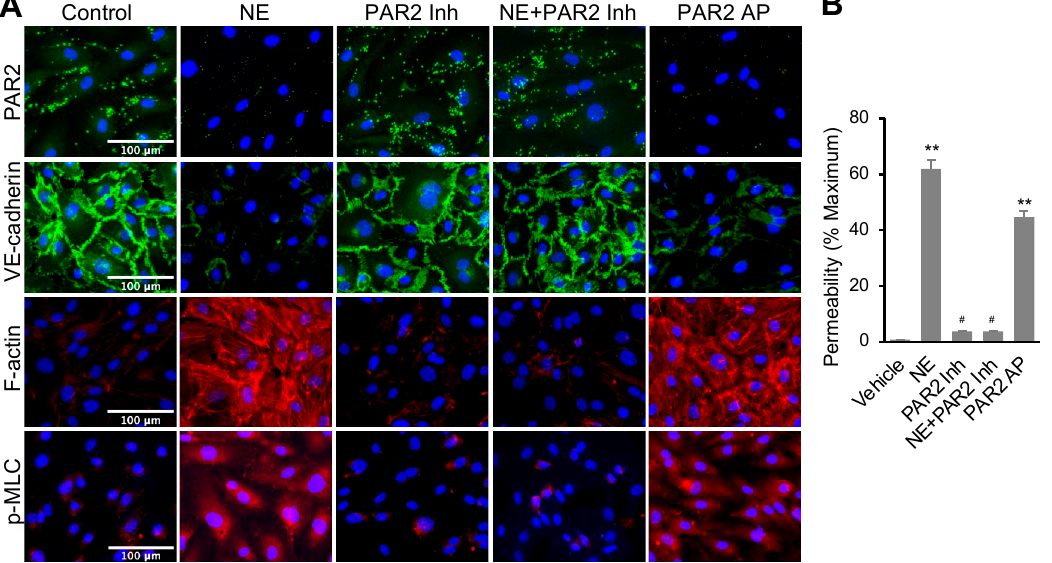
Figure 2. NE regulated VE-cadherin, actomyosin cytoskeleton, and permeability in hECs through activating protease-activated receptor 2 (PAR2). ( A ) Immunofluorescence images of PAR2 (green), VE-cadherin (green), F-actin (red), or p-MLC (pSer19, red) and nuclei counterstaining DAPI (blue). hEC cells were treated with NE (20 nM) or PAR2 agonist (PAR2-AP, 7.5 μ M) in the presence or absence of PAR2 inhibitor (1 μ M) for 16 h. Images were taken at 20x using a fluorescence microscope; scale bar: 100 μ m. ( B ) Graph showing percentage permeability of endothelial monolayer treated with 20 nM NE, 7.5 μ M PAR2 agonist, and 1 μ M PAR2 inhibitor. Permeability assay was carried out with Lucifer Yellow dye. All data are expressed as mean ± SD of three independent experiments. ** p < 0.01 vs. vehicle control group, # p < 0.05 vs. NE group. NE: neutrophil elastase, PAR2 Inh: protease-activated receptor 2 inhibitor (I191), PAR2 AP: protease-activated receptor 2